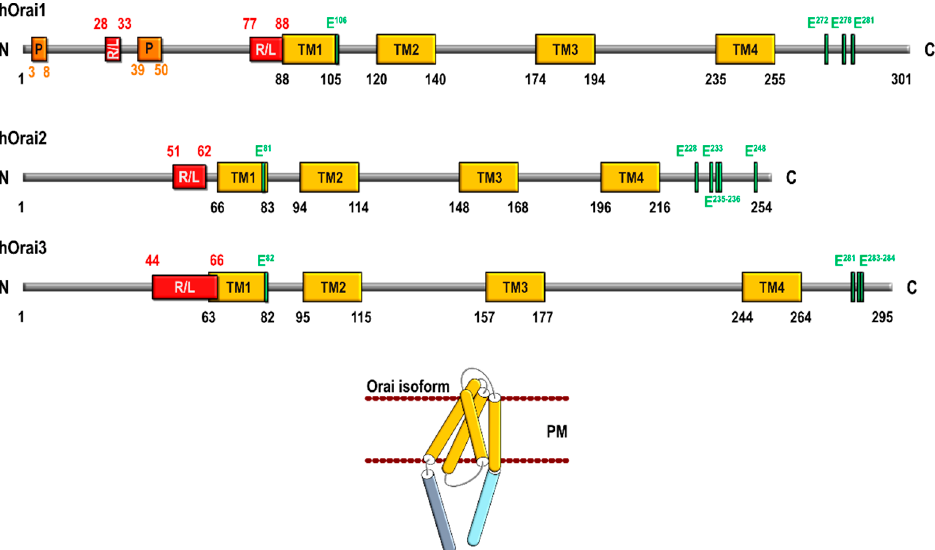
Figure 1. Schematic structure of human Orai1, Orai2, and Orai3 and Orai subunit architecture. R/L, arginine and lysine-rich (positively charged) region; P, proline-rich region; PM, plasma membrane; TM, transmembrane domain.